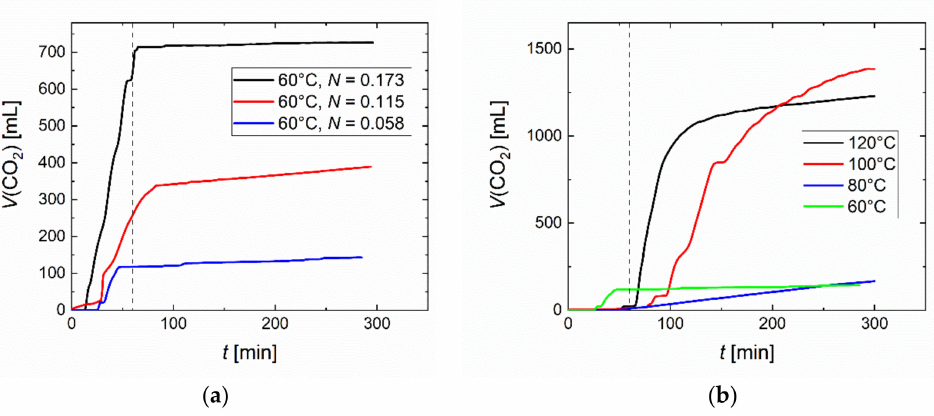
Figure 3. CO 2 uptake monitored by mass-flow controller from experiments at T = 60 ◦ C ( a ) and N = 0.058 ( b ). PO dosing ended after 60 min (dashed